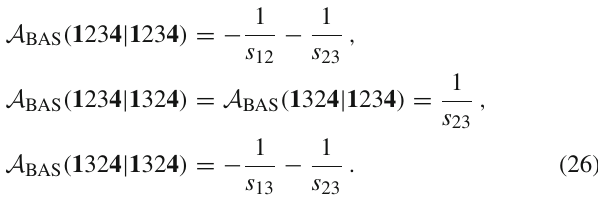
not employ the dimensional reduction or the operator T (cid:3) (cid:3) to convert gravitons to photons.